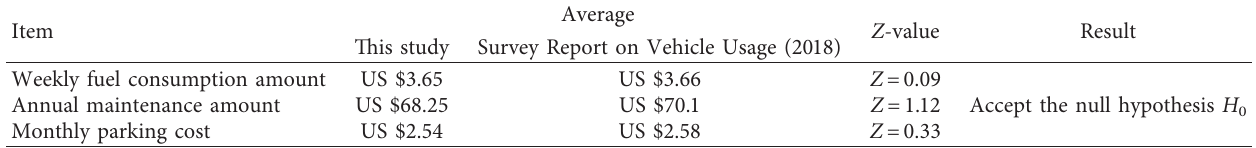
Table 3: Results of the samples’ representative tests.